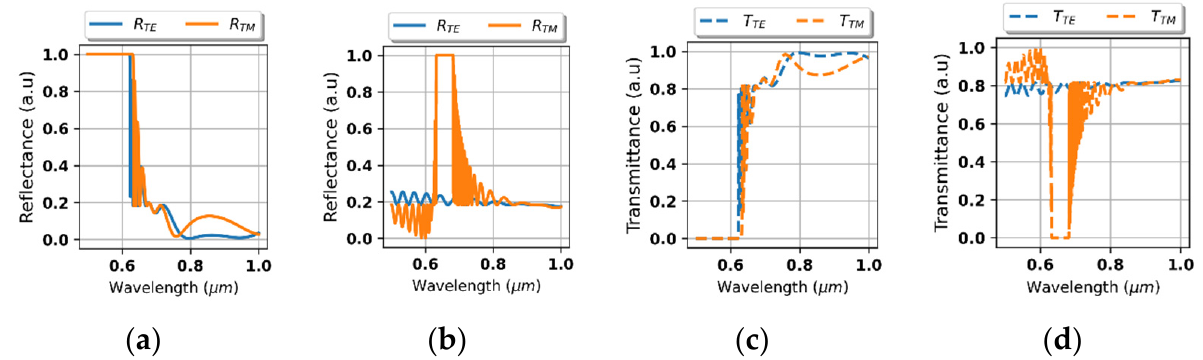
Figure 6. Spectral characteristics of reflectance ( a , b ) and transmittance ( c , d ) for waves impinging from the air side θ inc = 0° ( a , c ) and from the substrate side θ inc = 180° ( b , d ).